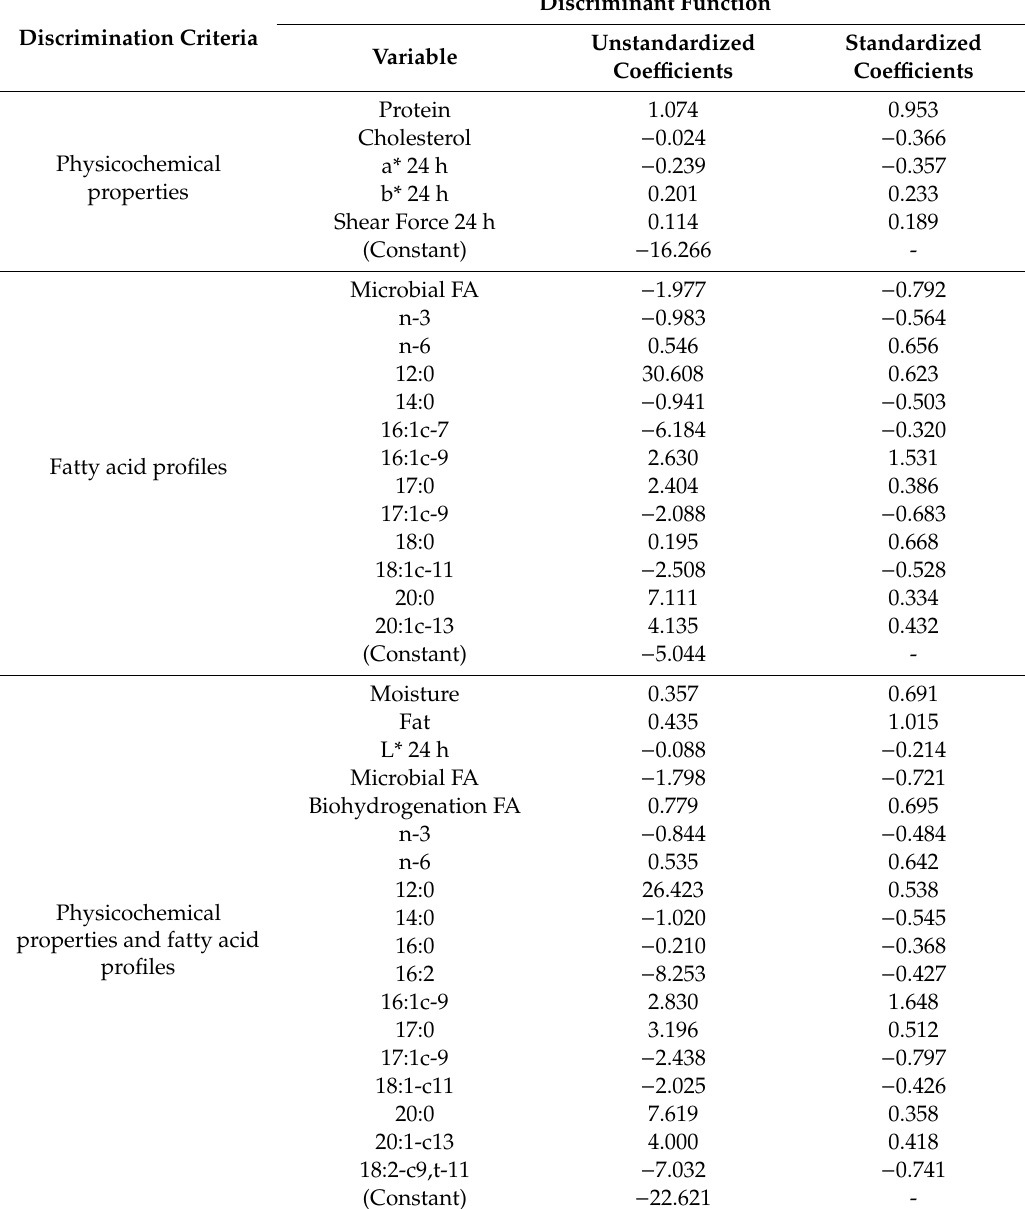
Table 4. Estimated coe ffi cients of the canonical discriminant function on the predictor variables, in discriminant analyses of finishing systems based on meat physicochemical properties, fatty acid profiles or